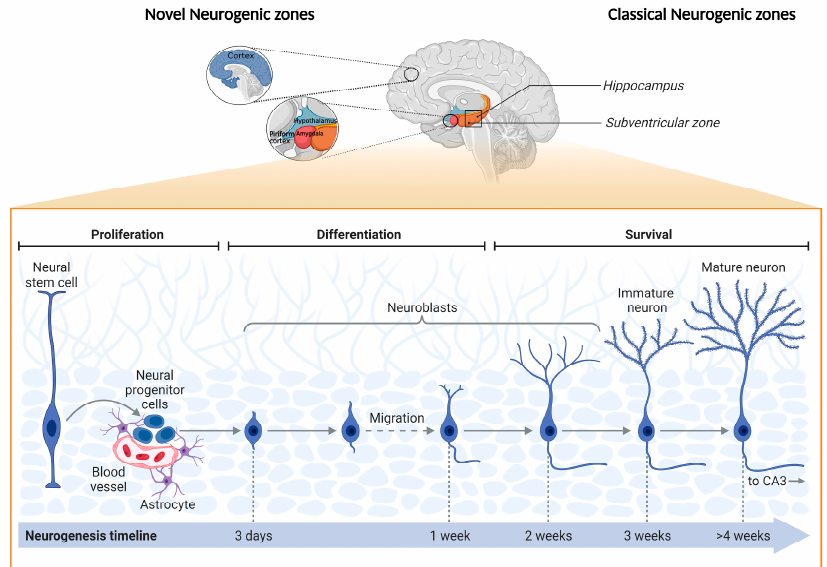
Figure 1. Schematic representation of “novel” and classical adult neurogenic zones, as well as their main cellular stages. Representation of the source of progenitor cells in different brain regions: the “novel” adult neurogenic zones—the prefrontal cortex, hypothalamus, striatum, amygdala, and piriform cortex—and the prime adult neurogenic zones—the hippocampus and subventricular zone (SVZ) [5]. The generation of new neurons has been extensively studied in the hippocampal dentate gyrus (DG) and the SVZ. In the DG, progenitor cells located in the subgranular zone (SGZ) divide and give rise to quiescent radial glial cells (neural stem cells) that can commit to neural progenitor cells and mature into neurons. These neurons will migrate to the granule cell layer to integrate into existing hippocampal circuitries. Experimental evidence has proposed that progenitor cells can deviate from the normal route in the DG and SVZ and differentiate as well as maturate in different brain regions, namely the prefrontal cortex, striatum, substantia nigra, and amygdala, considered the “novel neurogenic zones” [5,6]. Figure created with BioRender.com (Accessed on 25 th October 2022).